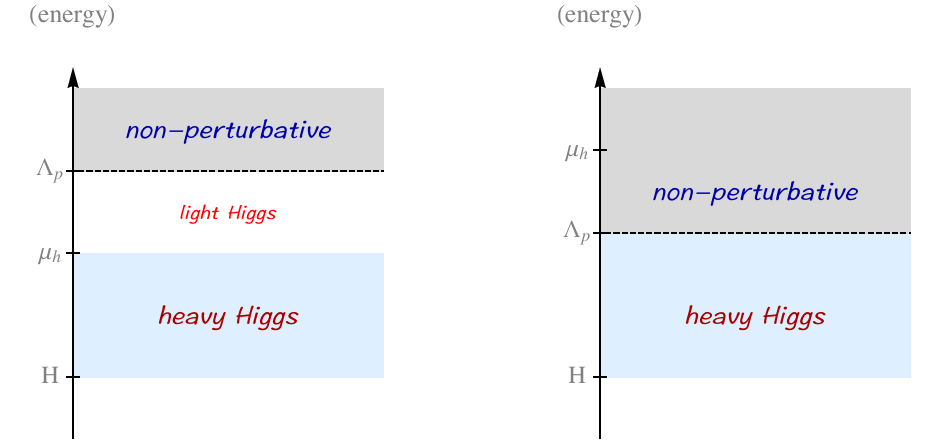
Figure 2 . Illustration of the energy scales with two kinds of